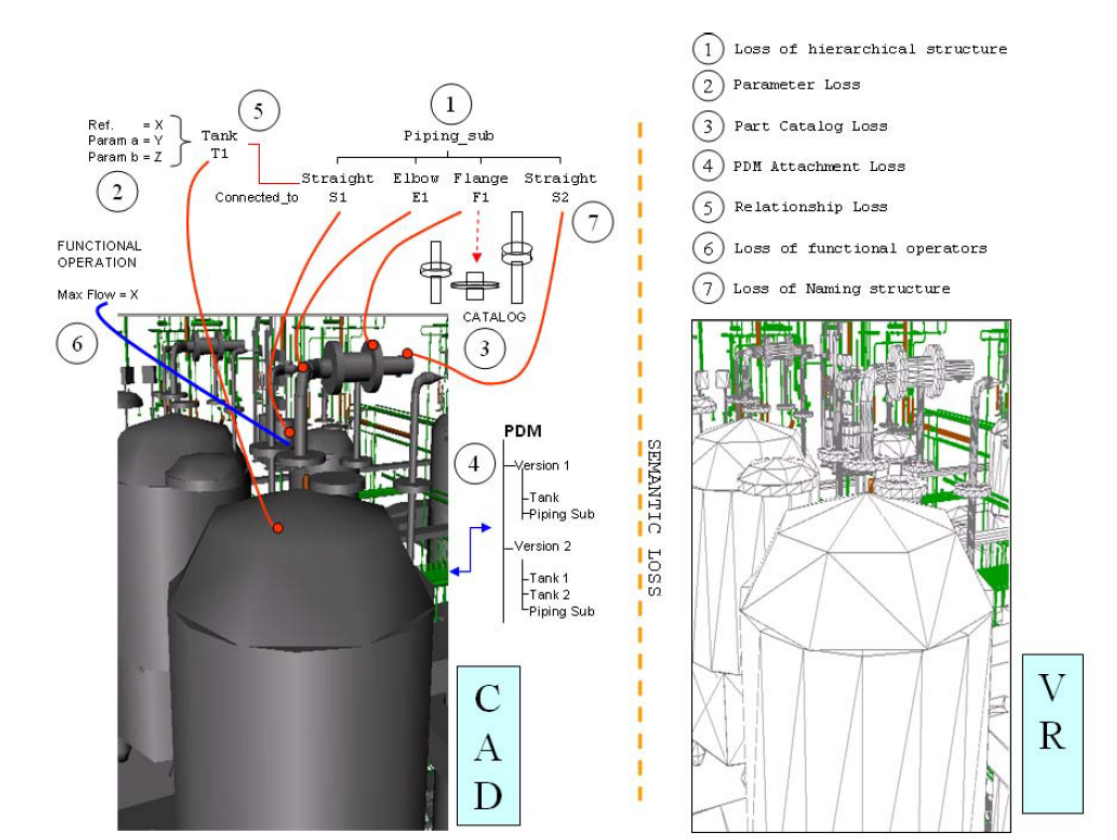
Figure 1. Examples of “Semantic loss” of three-dimensional Computer-aided Design (3D CAD) Models conversion to STEP (for various purposes, such as Virtual Reality visualization and interaction with the model). Adapted from